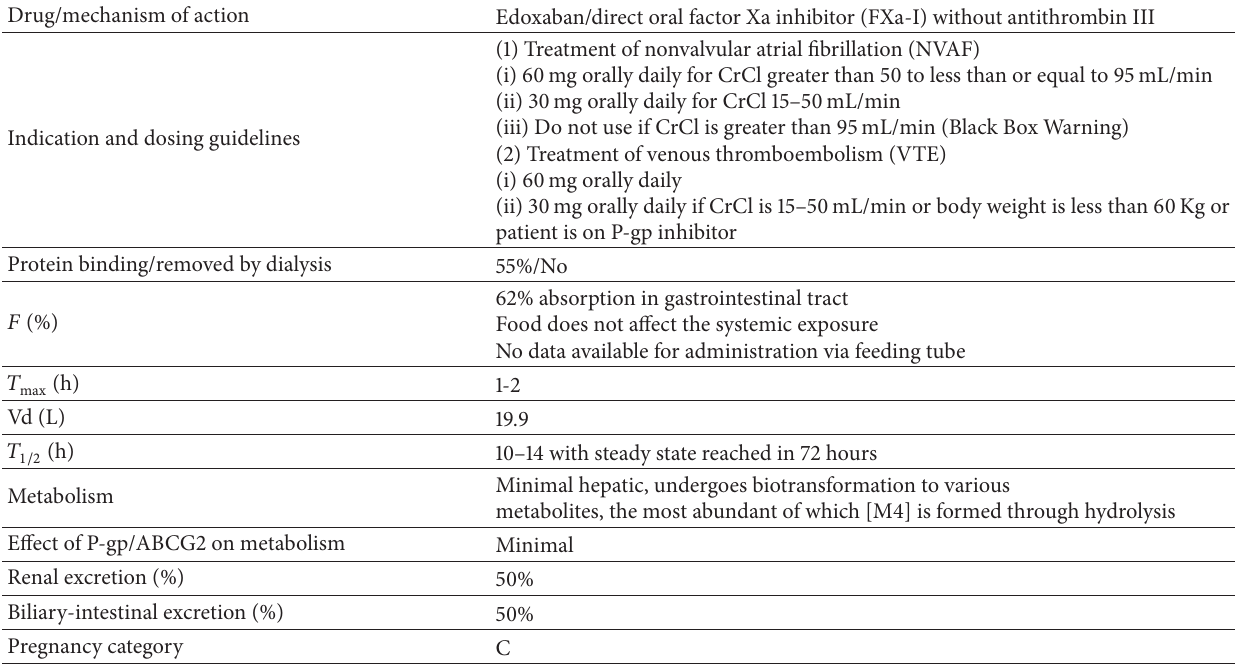
Table 1: Edoxaban pharmacodynamics and pharmacokinetics [16–21]. Drug/mechanism of